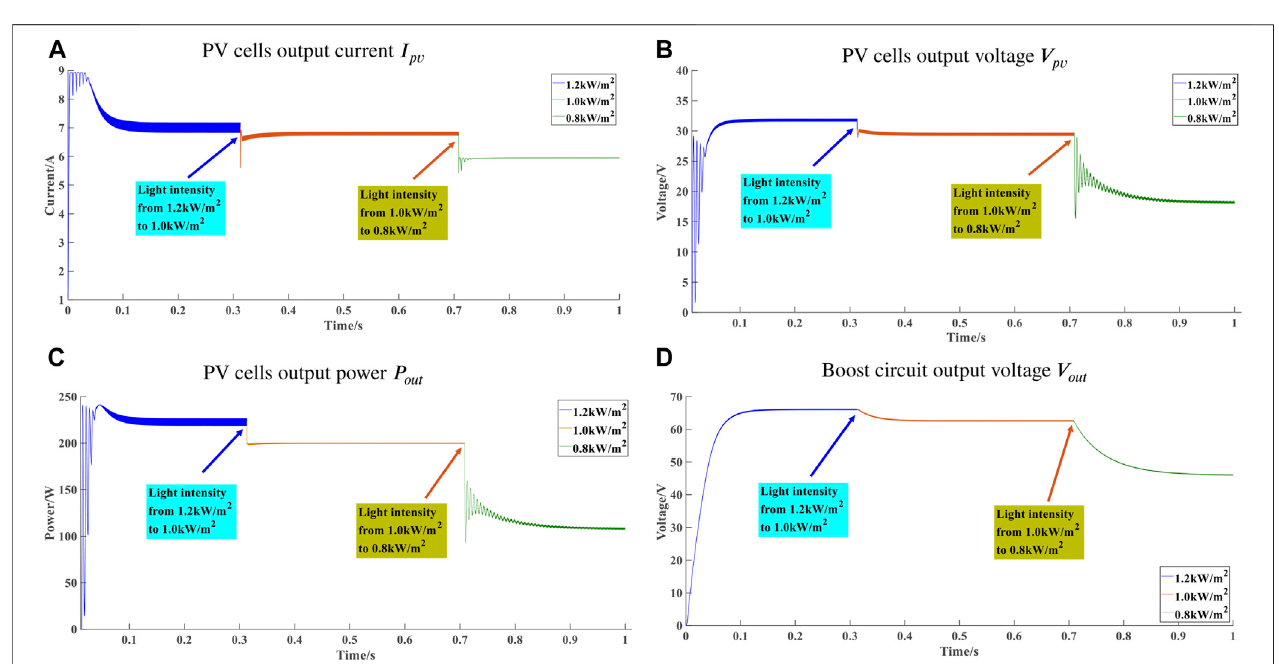
FIGURE8| TheoutputwaveformofPVcellswhentheirradiationchanges. (A) PVcellsoutputcurrentIpv. (B) PVcellsoutputvoltageVpv. (C) PVcellsoutputpower Pout. (D) Boost circuit output voltage Vout.